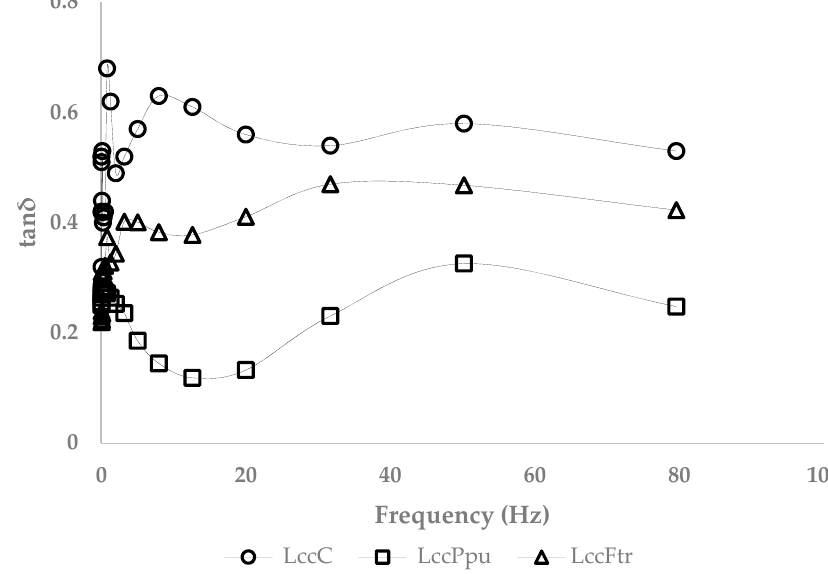
Figure 2. Loss factor of the arabinoxylan gels (6%), formed with laccase C (circles), Ppu (squares), and Ftr (triangles).